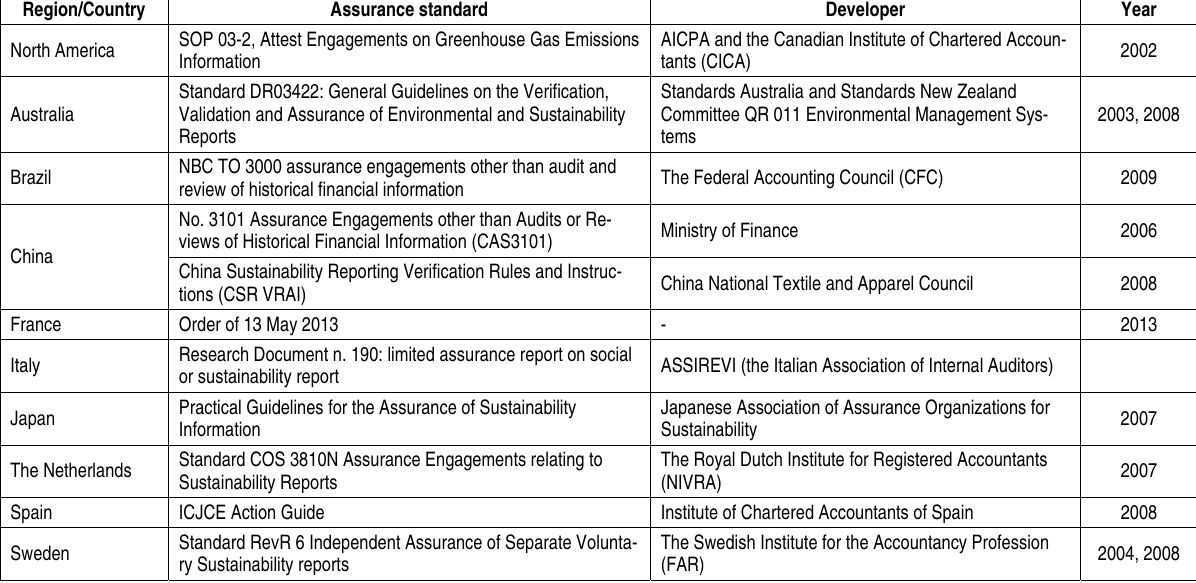
Table 7. Regulatory instruments for assurance of